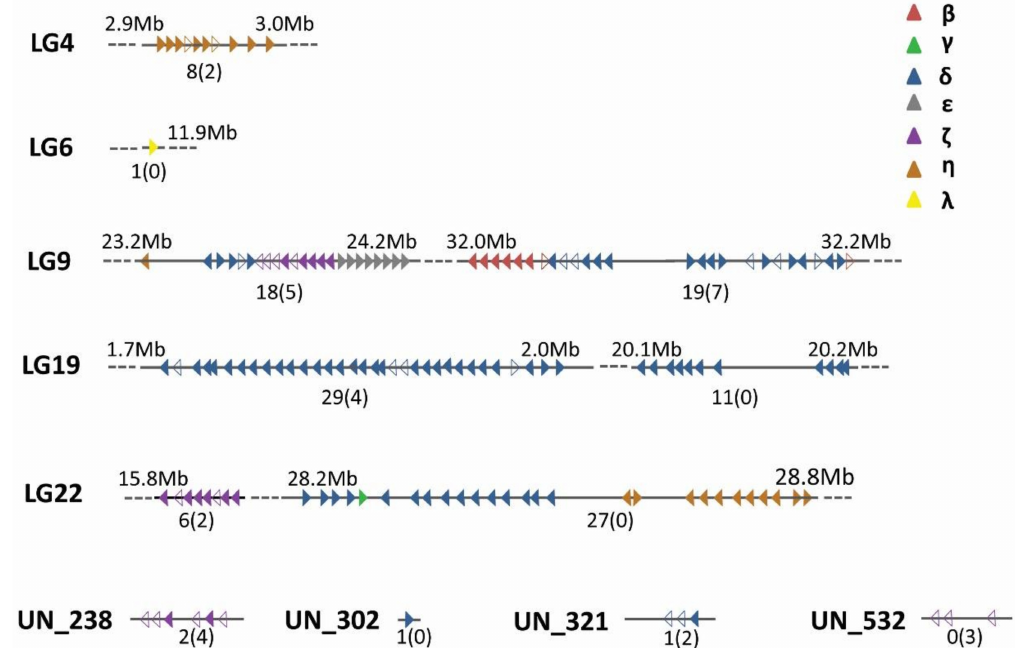
Figure 1. Chromosomal distribution of Chinese perch OR genes. The majority of Chinese perch OR genes were organized in eight clusters on five chromosomes. The other 13 OR genes were located on four scaffolds. The position of each cluster is shown above the chromosomes, in Mb. The numbers of functional genes and pseudogenes in each cluster are shown below the chromosomes/scaffolds. OR genes are depicted as filled triangles (functional genes) and hollow triangles (pseudogenes). Triangles pointing to the right mean the + strand; triangles pointing to the left mean the − strand; the OR gene distance is drawn to scale. Genes are colored according to their